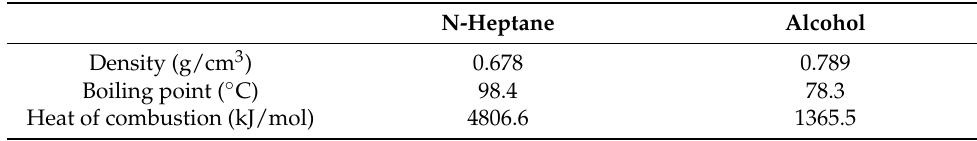
Table 1. Some properties of the fuels in the experiment.